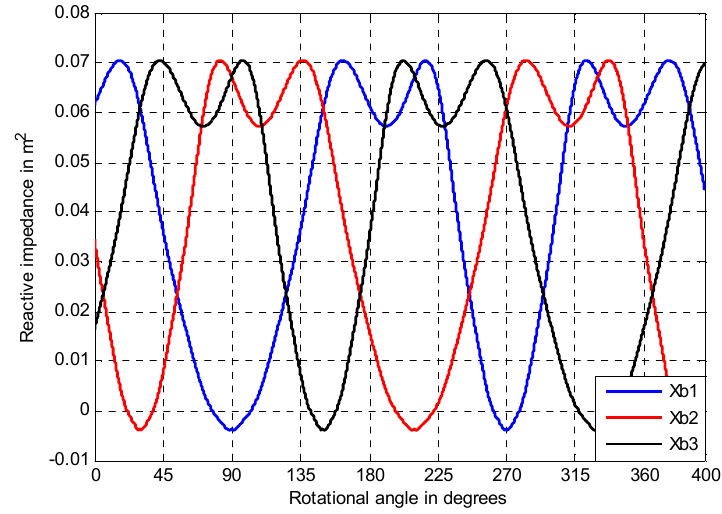
Figure 15. Variations of the blade reactance as a function of the rotational angle.